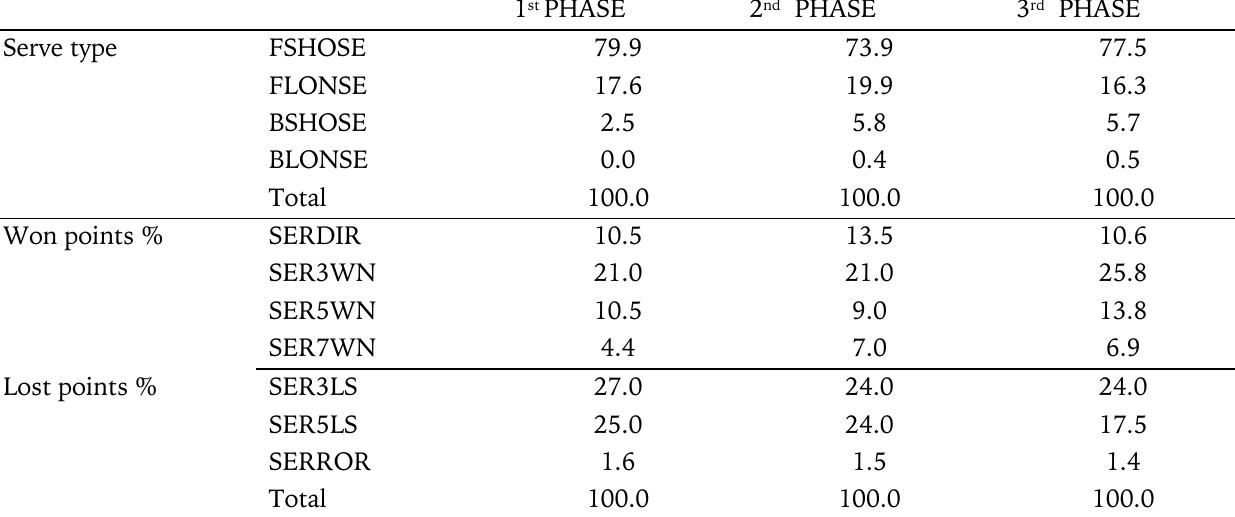
Results of analysis of serve type and outcome in different phases of the match of all sample